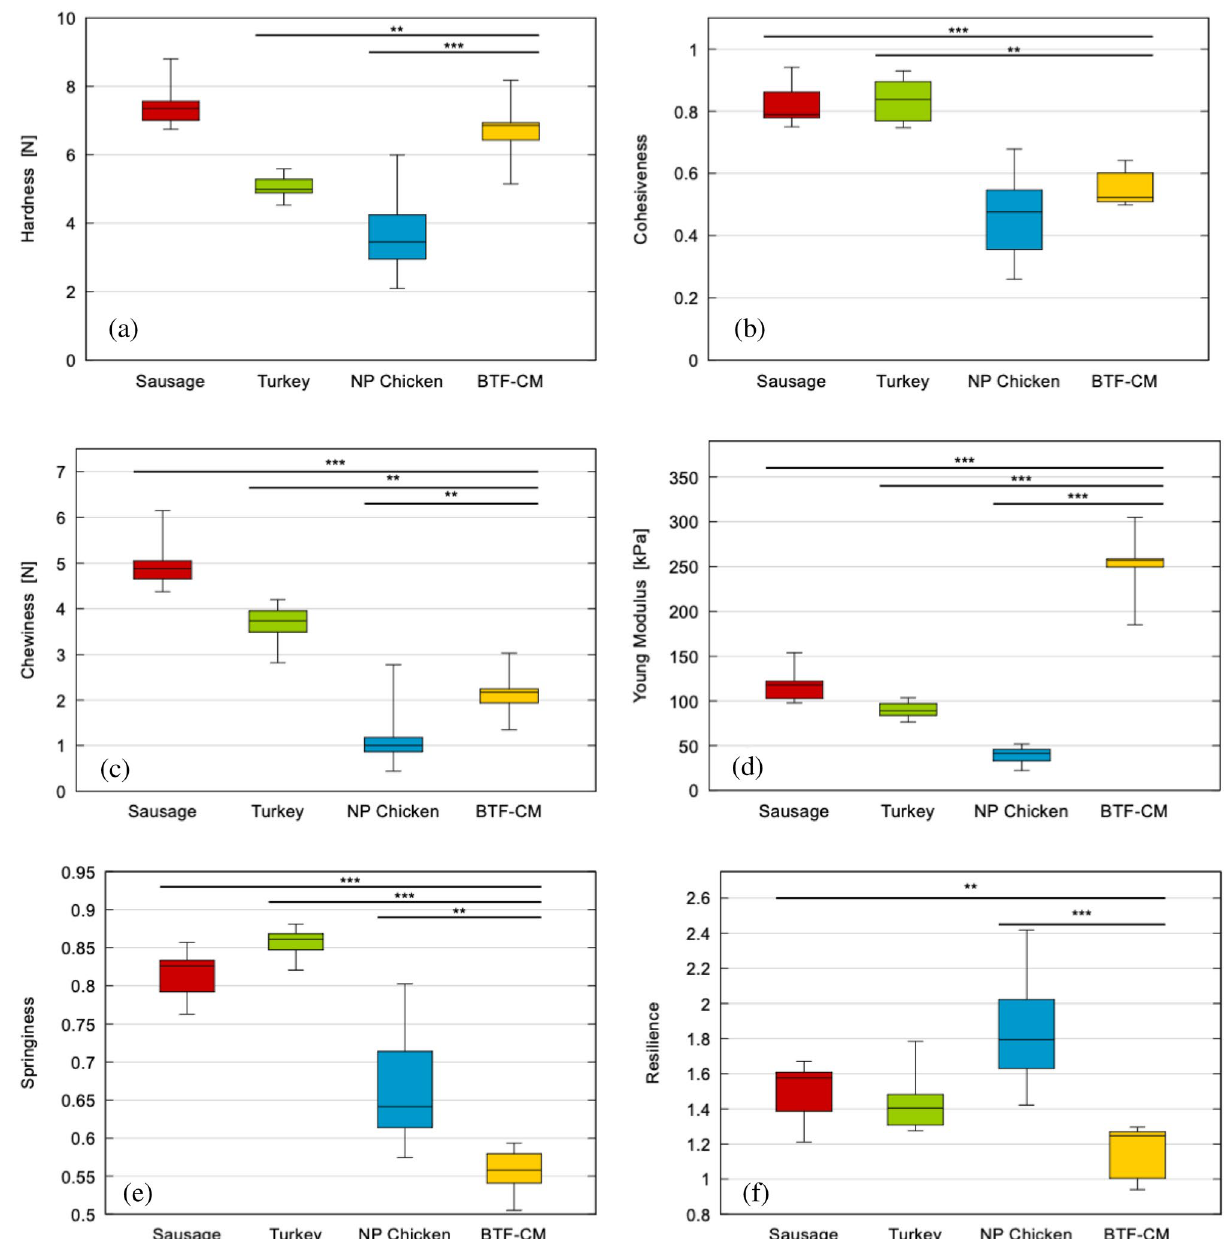
Figure 3. Box plot of hardness (a) , cohesiveness (b) , chewiness (c) , Young’s modulus (d) , springiness (e) , and resilience (f) of the three traditional meat references and the cultured meat (p values < 0.01 *; < 0.001 **; < 0.0001